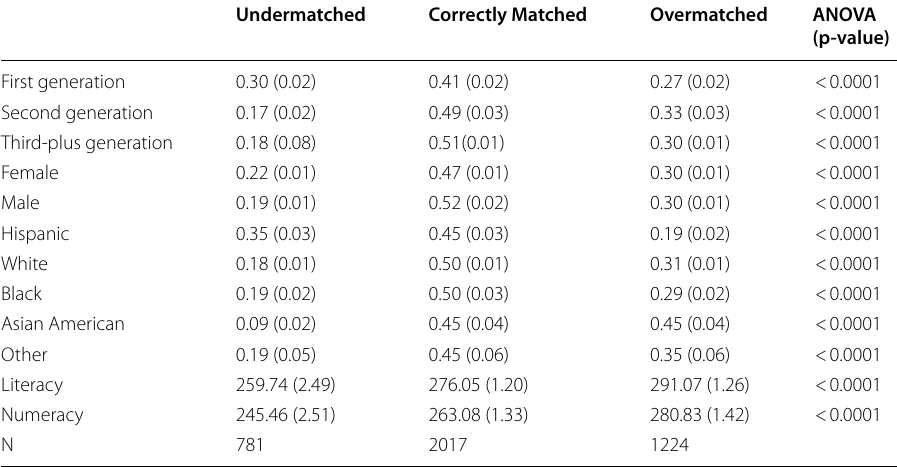
Table 3 Selected Descriptive Statistics by Job-Education Mismatch, All Workers, PIAAC 2012/2014